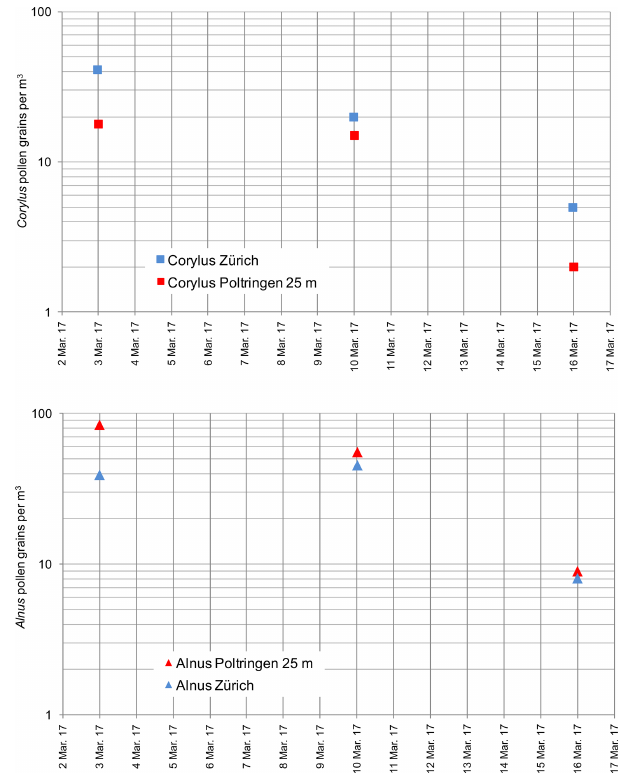
Figure 11. Concentrations of pollen of the genera Corylus and Al- nus collected in Poltringen with the new particle collection sys- tem (PCS) operated on board the multicopter UAV during hover- ing at 25ma.g.l. on 3, 10, and 16 March 2017 in comparison with pollen concentrations of the same genera published by MeteoSwiss in Zürich measured by using a Burkard pollen sampler. The lowest altitude above ground level data for Poltringen are available from 25ma.g.l. for all 3 sampling